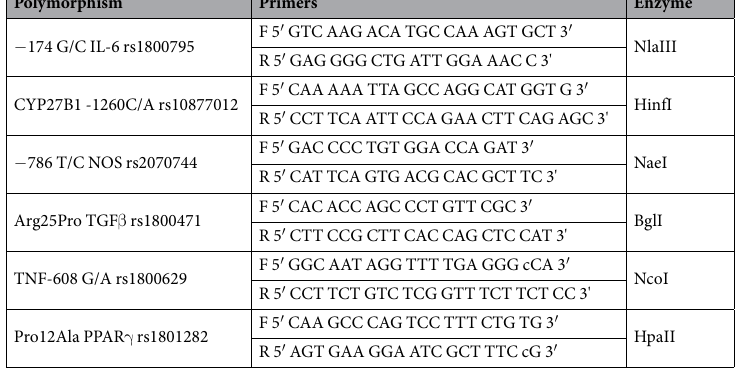
Table 6. Primers and restriction enzymes.